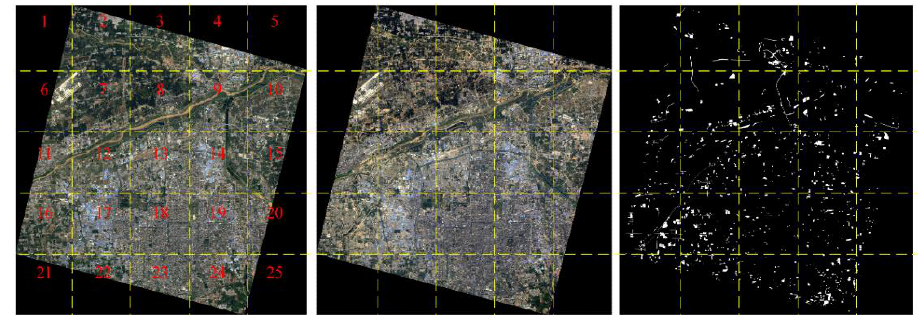
Figure 3. Dataset division.